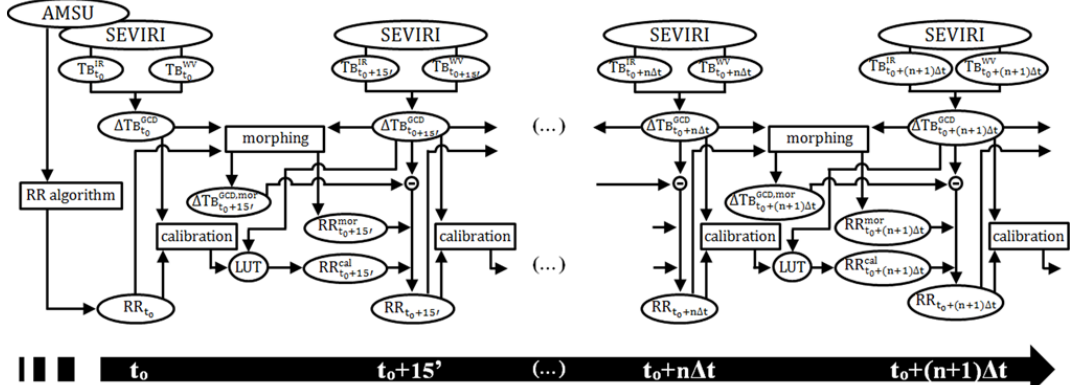
Fig. 2. Scheme of the Precipitation Evolving Technique